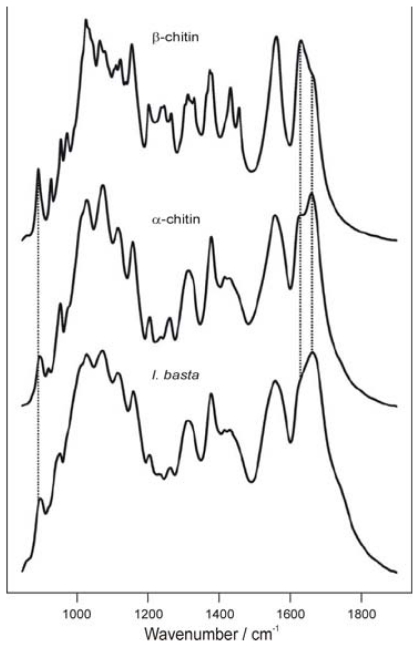
FTIR spectra of β-chitin from T. rotula, α-chitin from crabs and I. basta chitin after NaOH and H2O2 treatment. Dashed vertical lines are drawn to mark characteristic differences between α- and β-chitin. Reprinted from Journal of Structural Biology 168, 2009, Brunner, E., Ehrlich, H., Schupp, P., Hedrich, R., Hunoldt, S., Kammer, M., Machill, S., Paasch, S., Bazhenov, V.V., Kurek, D.V., Arnold, T., Brockmann, S., Ruhnov, M., Born, R., Chitin-based scaffolds are an integral part of the skeleton of the marine demosponge lanthella basta, 539–547, Copyright (2010), with permission from Elsevier [110].